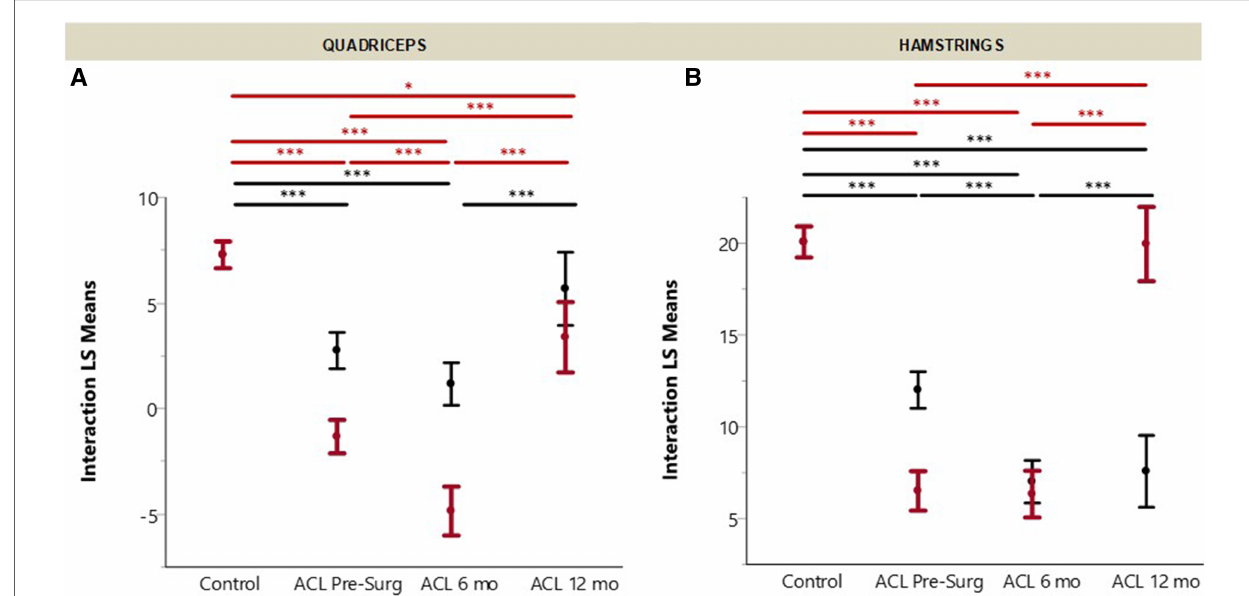
FIGURE 5 ACL recovery of ( A ) hamstrings and ( B ) quadriceps in the injuredand uninjured limbs. Recovery measured by multiplication of average fi ring rate (AvgFR), log of MUAP divided by mass [log(MUAP/mass)], and recruitment threshold [CubeRoot(RecThr)]. (Error bars denote 95% con fi dence intervals of the